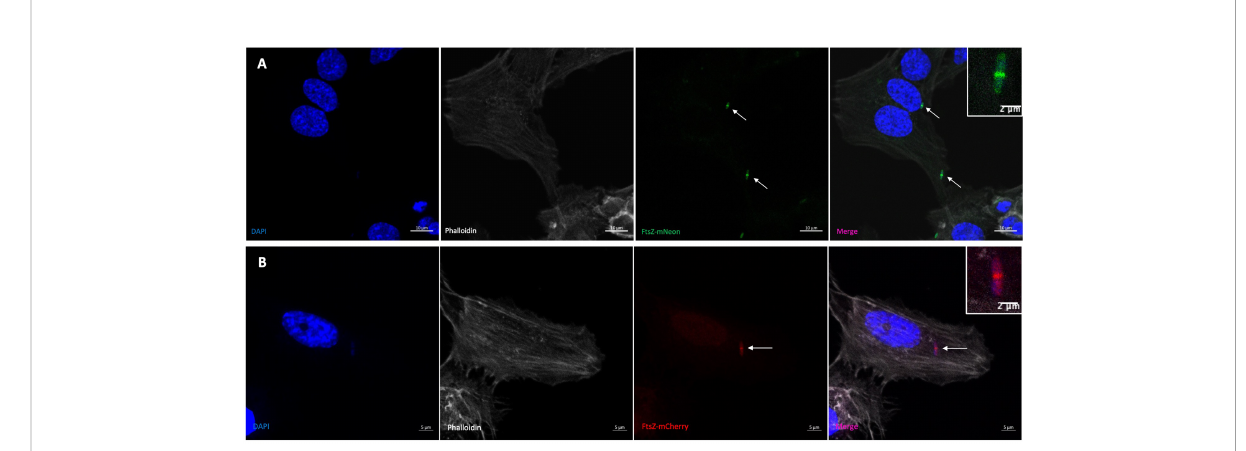
FIGURE 1 Visualisation of the FtsZ Z-ring in normal growth conditions by confocal microscopy. (A) K12/FtsZ-mNeon cells fi xed during human cell infection. An internalisation experiment using gentamicin to kill extracellular bacteria showed this strain had an infection rate of 4.1% in hCMECs. (B) EV36/FtsZ-mCherry cells fi xed during human cell infection. Arrows pointing to bacterial Z-rings. DAPI stain is shown in blue, phalloidin stain is shown in grey, FtsZ-mNeon is shown in green, and FtsZ-mCherry is shown in